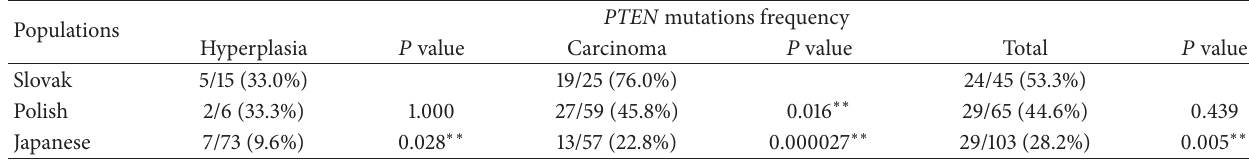
Table 4: Frequency of PTEN mutations in Slovak, Polish, and Japanese population.